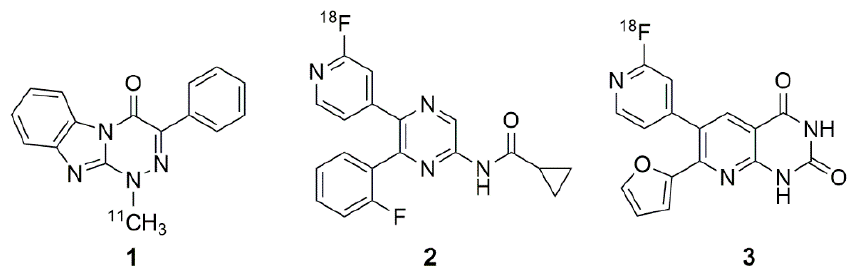
Figure 1. Carbon-11 ( 1 ) and fluorine-18 ( 2 and 3 )-labeled radiotracers for PET imaging of the adenosine A 2B receptor.